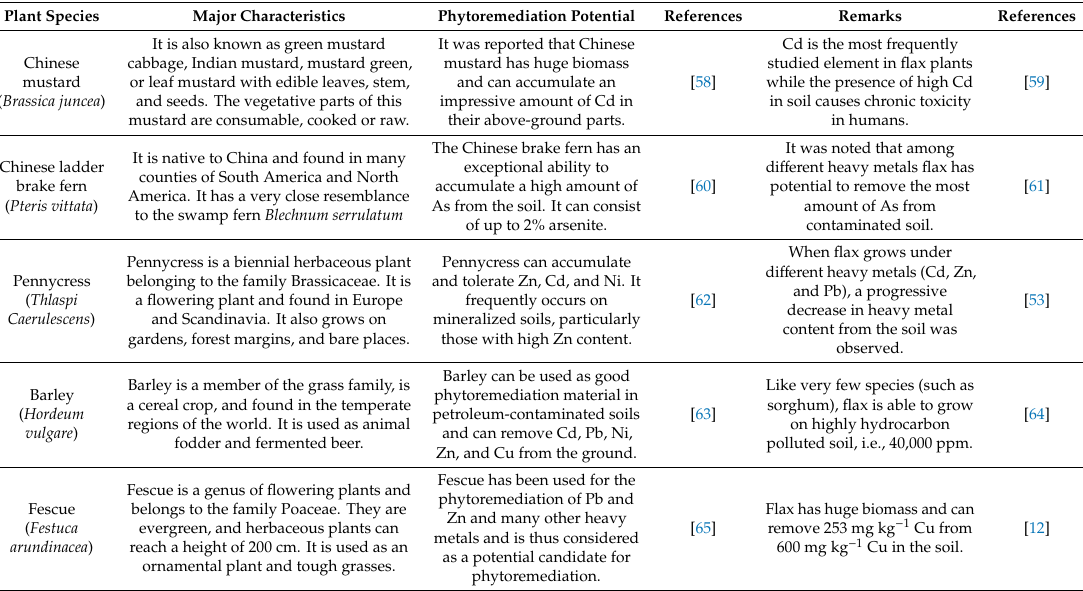
Table 1. Some essential plants which are considered good candidates for phytoremediation and comparison with the phytoremediation potential and significant characteristics of